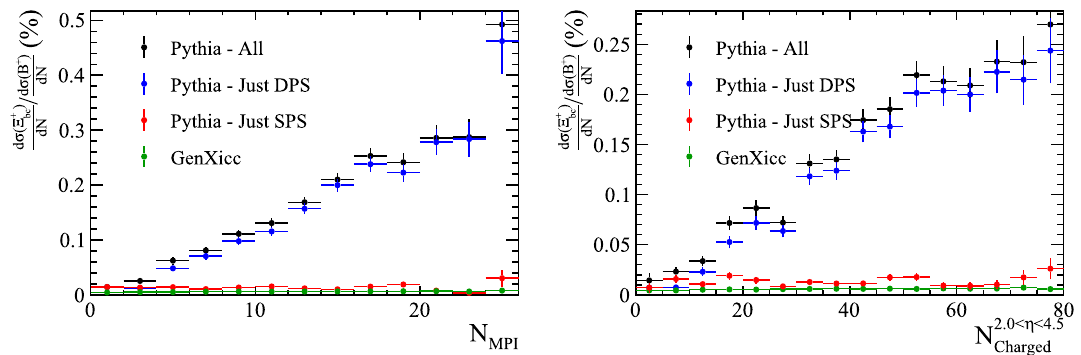
Fig. 15 Differential cross-section of (cid:2) + baryons as a function of (left) the number of parton interactions in a collision and (right) the number of bc charged tracks within the rapidity region 2 . 0 < y < 4 . 5, as generated with GenXicc and Pythia